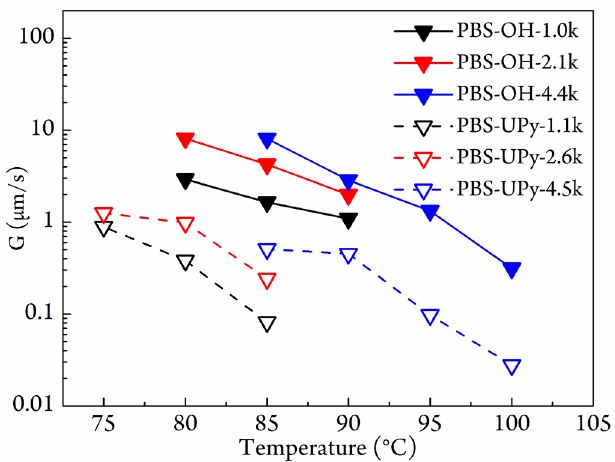
Figure 7. The spherulite growth rates of PBS-OH and PBS-UPy samples at different crystallization temperatures.